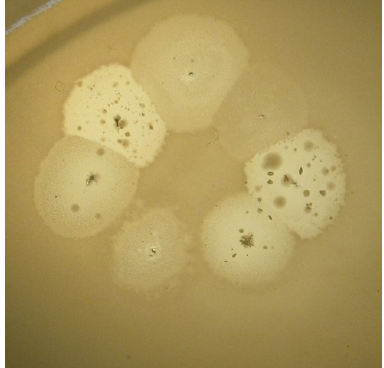
Figure 10. Growth of TL phage variants on the lawn P. aeruginosa